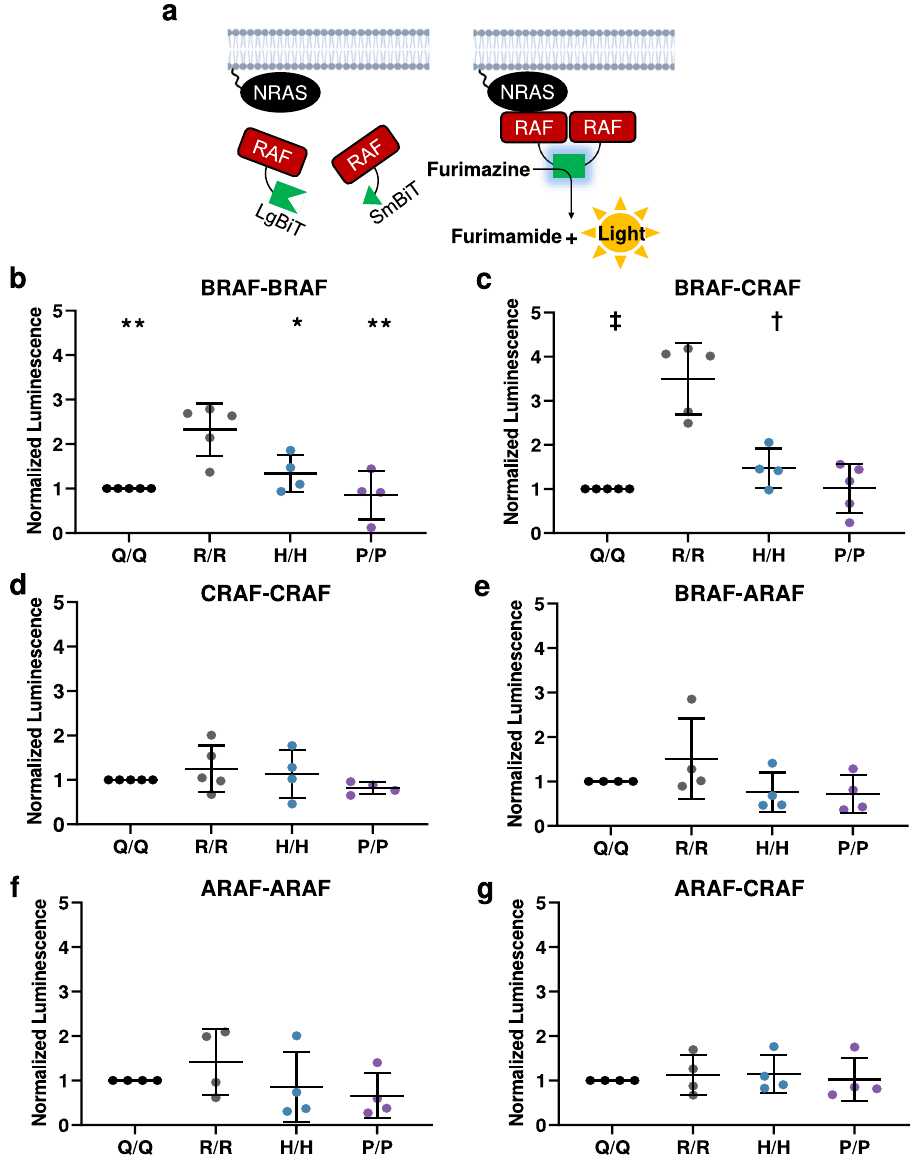
Fig. 6 Melanomagenic NRAS mutants enhance RAF dimerization. a Schematic representation of the RAF NanoBiT assay in which each RAF isoform is tagged with either LgBiT or SmBiT. Dot plots of normalized luminescence intensity in TN 61X/X MEFs infected with adenovirus expressing BRAF-LgBiT and BRAF-SmBiT ( b ), BRAF-LgBiT and Craf-SmBiT ( c ), CRAF-LgBiT and CRAF-SmBiT ( d ), ARAF-LgBiT and BRAF-SmBiT ( e ), ARAF-LgBiT and ARAF-SmBiT ( f ), or ARAF-LgBiT and CRAF-SmBiT ( g ). Luminescence intensity was normalized to crystal violet staining for each well. Dot plot data are presented as mean values + / − SD where each dot represents one biological replicate. The following biologically independent replicates per genotype were examined over fi ve independent experiments (BRAF-BRAF: Q/Q = 5, R/R = 5, H/H = 4; P/P = 4; BRAF-CRAF: Q/Q = 5, R/R = 5, H/H = 4; P/P = 5; CRAF-CRAF: Q/Q = 5, R/R = 5, H/H = 4; P/P = 4; BRAF-ARAF: Q/Q = 4, R/R = 4, H/H = 4; P/P = 4; ARAF-ARAF: Q/Q = 4, R/R = 4, H/H = 4; P/P = 4; ARAF-CRAF: Q/ Q = 4, R/R = 4, H/H = 4; P/P = 4). One-way ANOVA with a Tukey ’ s post-test was used to compare data between each genotype. NRAS mutant samples statistically different from NRAS 61R/R samples are indicated in the fi gure. Adjusted p -values for all comparisons can be found in Supplementary Table 4d. * p < 0.05, ** p < 0.01, † p < 0.001, ‡ p < 0.0001. Source data are provided as a Source Data fi